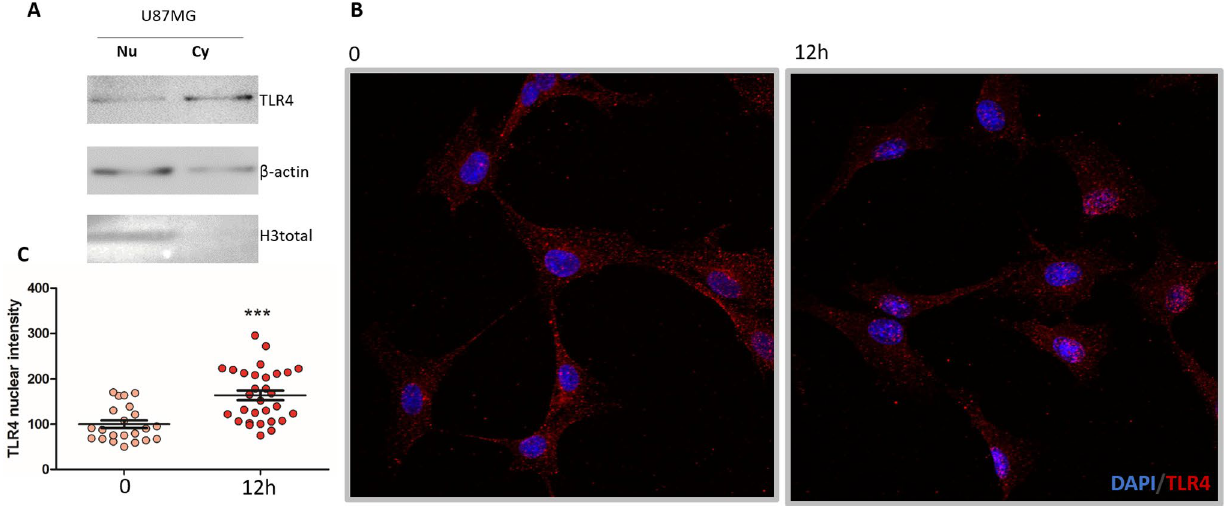
Figure 5. TLR4 localization in U87MG cells. ( A ) TLR4 presence was observed in nuclear (Nu) and cytoplasmic (Cy) protein fractions of U87MG cell line by Western blot analysis. Total H3 protein was used for nuclear protein enrichment control and β-actin for protein loading control. ( B ) The presence of TLR4 was detected in cytoplasmic and nuclear compartments in U87MG cells by immunofluorescence. TLR4 staining in the nucleus increased after 12 h of LPS stimulation. Cells incubated with anti-TLR4-secondary antibody anti-mouse-Alexa Fluor 568, in red, and with DAPI, in blue. 200 × magnification. ( C ) Values for nuclear fluorescence intensity for each analyzed cell n = 23 at 0 h and n = 25 at 12 h (*** p < 0.001 compared to 0 h,